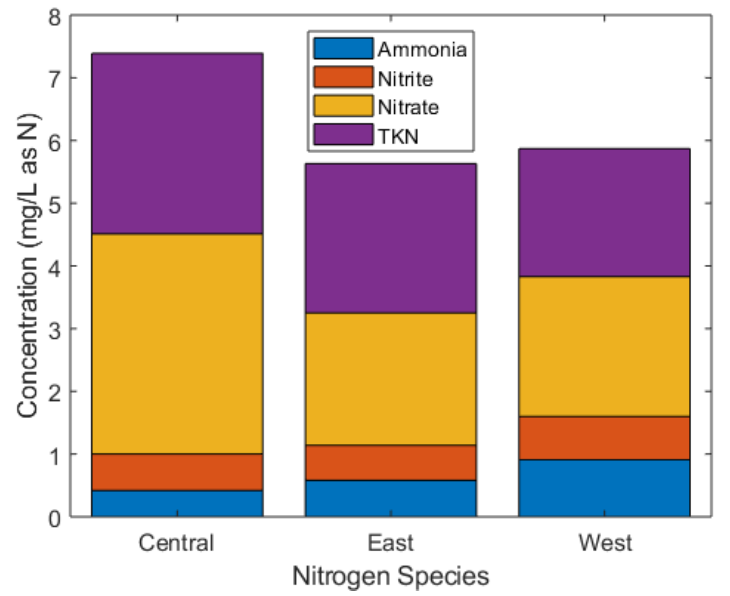
Figure A7. Nitrogen species comparison between sites. Figure A8. Nitrogen species comparison between